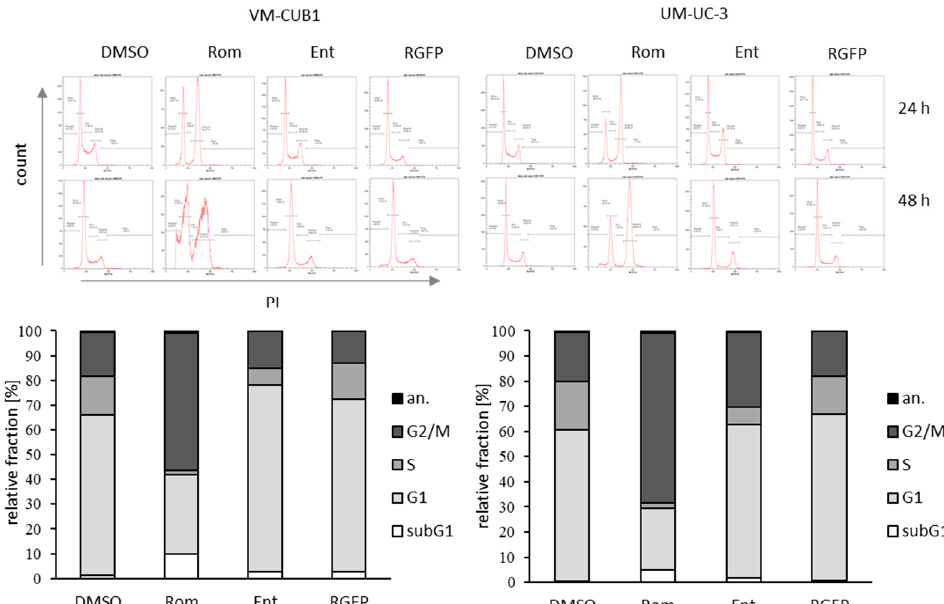
Figure 4. Cell cycle analysis of UCC after treatment with class I-specific HDACi. Cell cycle alterations were monitored by PI staining and flow cytometry 24 and 48 h after treatment with the indicated HDACi. Respective cell cycle phases were gated and percentage of cells within gates calculated. Example raw data of one representative experiment is visualized. The means for percentage of cells in the respective cell cycle phase after 48 h from three independent experiments are summarized in bar graphs.